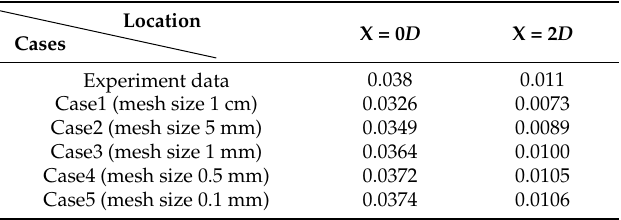
Table 1. Simulated bottom velocity response to the mesh size.